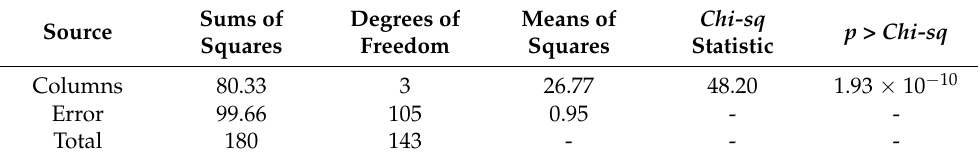
Table 13. Results of Friedman test for oil Midel 1204 with different concentrations of surfactant ROKwinol 80.